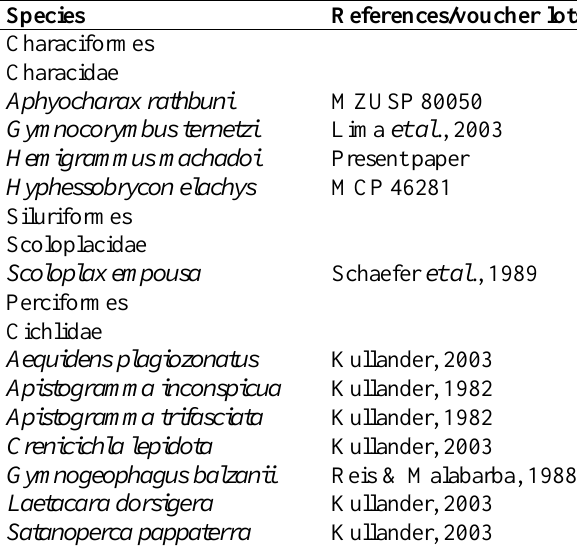
Table 3. Fish species known to be exclusively shared between the rio Paraguai/La Plata and rio Guaporé basins. Voucher lots documenting the occurrence of two species previously unrecorded for the rio Guaporé basin are